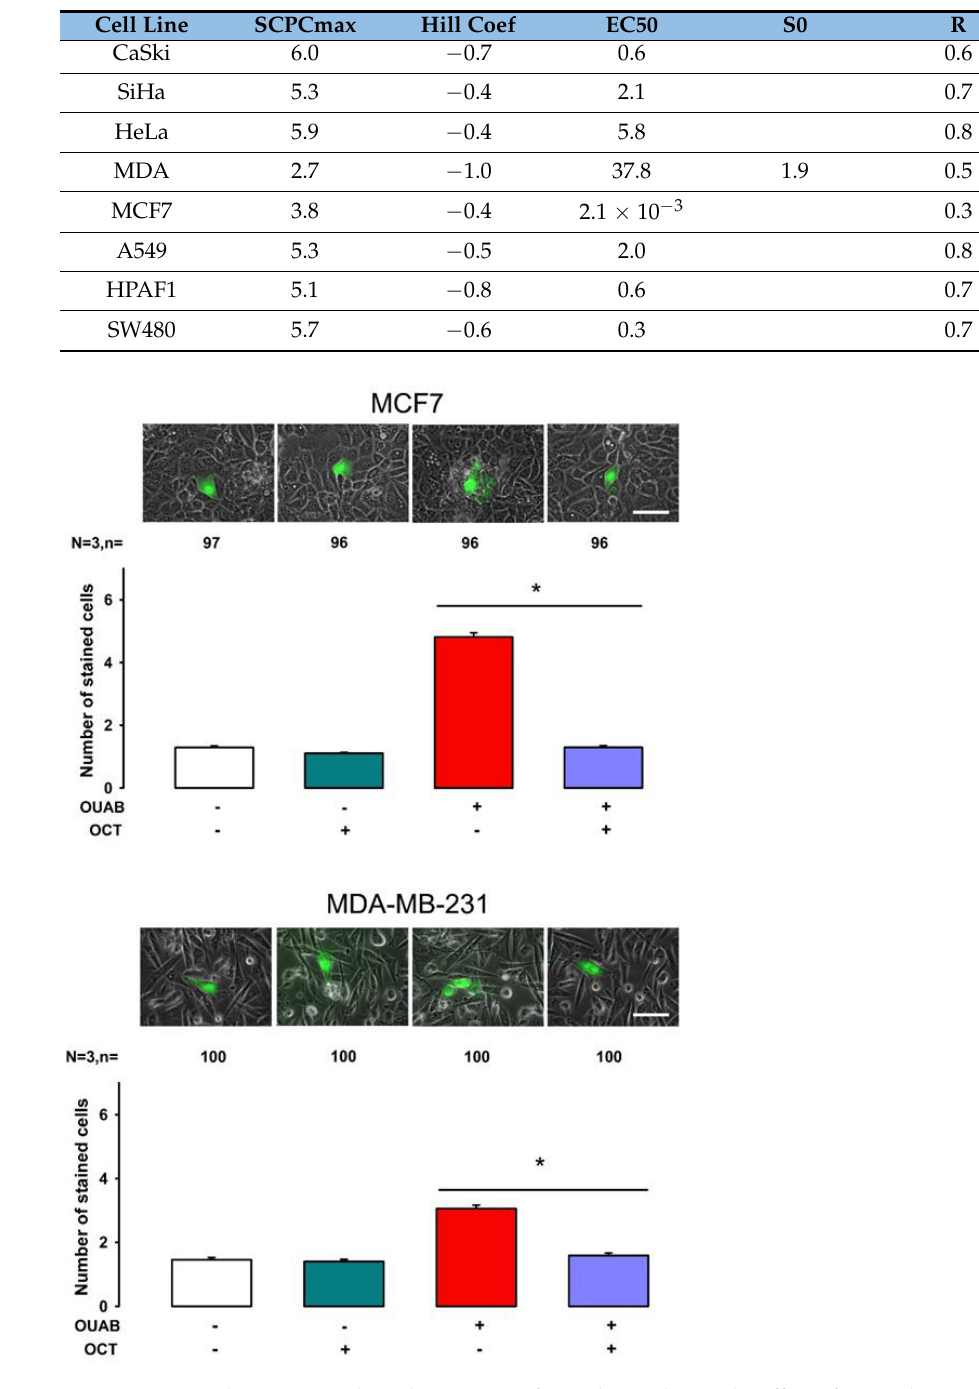
Figure 4. Octanol suppresses the enhancement of GJIC by ouabain. The effect of octanol was assayed in MCF7 (upper) and MDA-MB-231 (lower). The bar chart compares mSCPC ( ± SE) obtained after three independent trials of dye transfer assays, cells were treated in the conditions indicated at the bottom part of each bar. A representative image of each treatment is shown above the bars. The numbers above each bar indicate the total number of repeats. Asterisks indicate a statistically significant difference (Mann—Whitney Rank Sum Test. * indicates p < 0.05). Scale bar = 100 µm. 2.2. No Synthesis of New Units of Proteins or mRNA Is Required for Ouabain to Induce the Change of GJIC